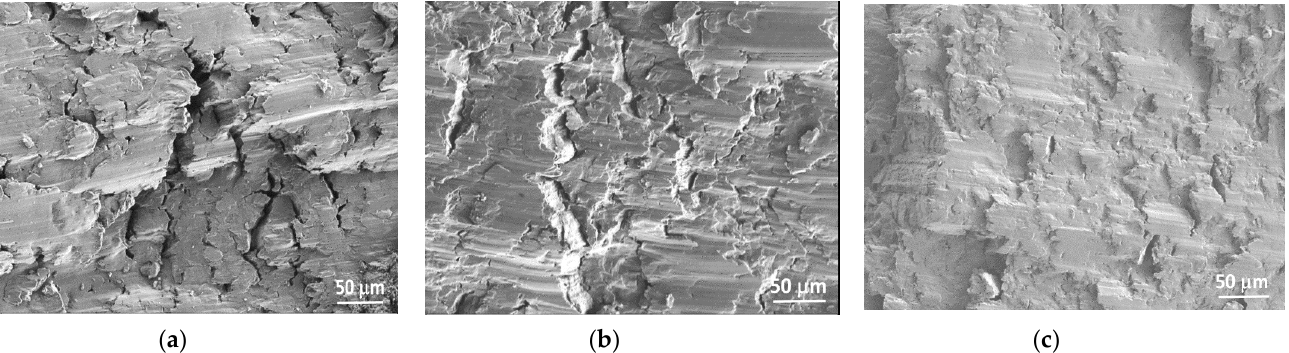
Figure 11. Fracture surface morphology of compressive failure samples: ( a ) Mg, ( b ) Mg-3Sn, and ( c ) Mg-3Sn + 0.2 GNP.